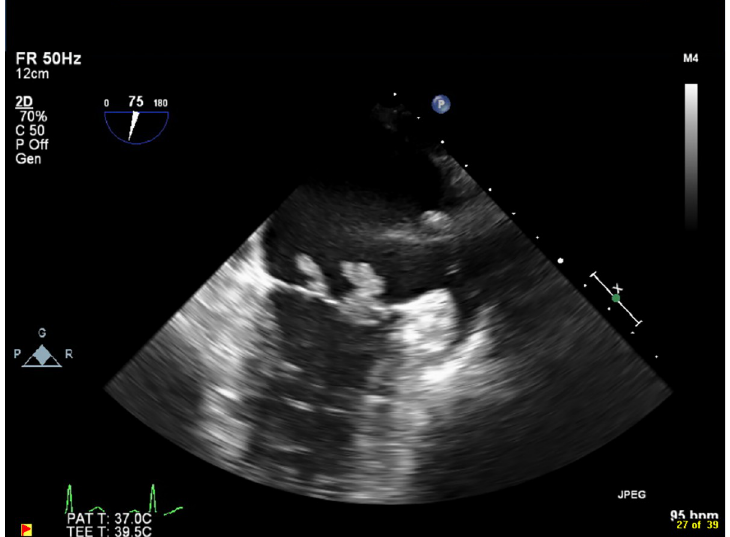
Fig 2. Example of large multiple mobile mitral valve vegetations (Grade 4 for mobility and Grade 2 for